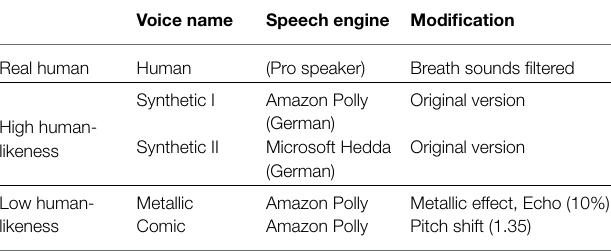
TABLE 1 | Description of the five experimental robot